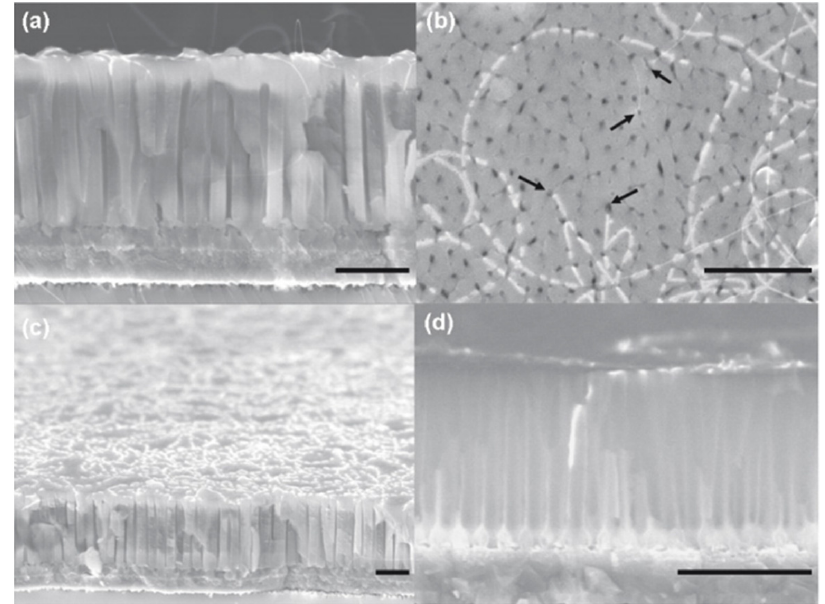
Figure 15. SEM images of CNTs grown inside the PAA template. ( a ) Cross-sectional view of PAA/CNTs. ( b ) Top PAA surface showing CNTs emerging from pores. ( c ) Tilted cross-sectional view of template and CNTs. ( d ) Cross-sectional view showing CNT initiating from catalyst layer. Scale bar = 500 nm. Reprinted with permission from Ref. [11]. IOP Science Copyright © 2023.